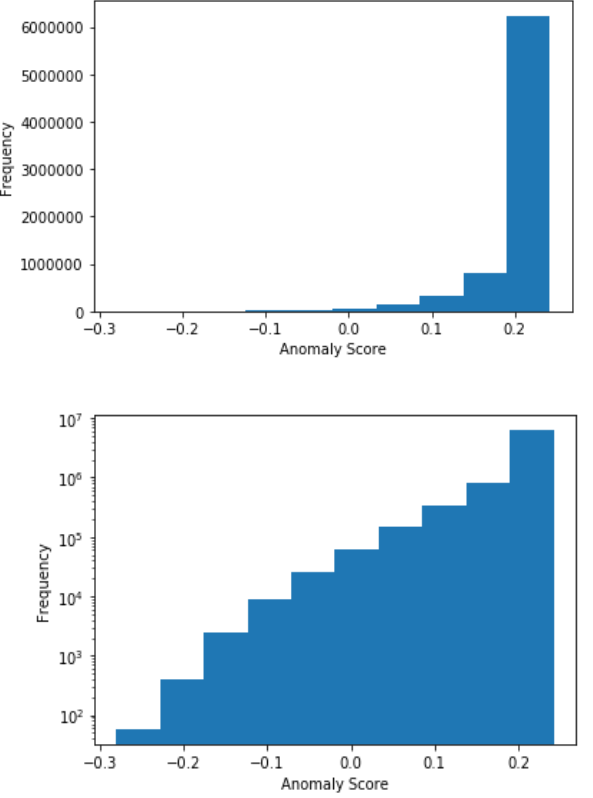
Figure 2. Histograms of Anomaly Scores